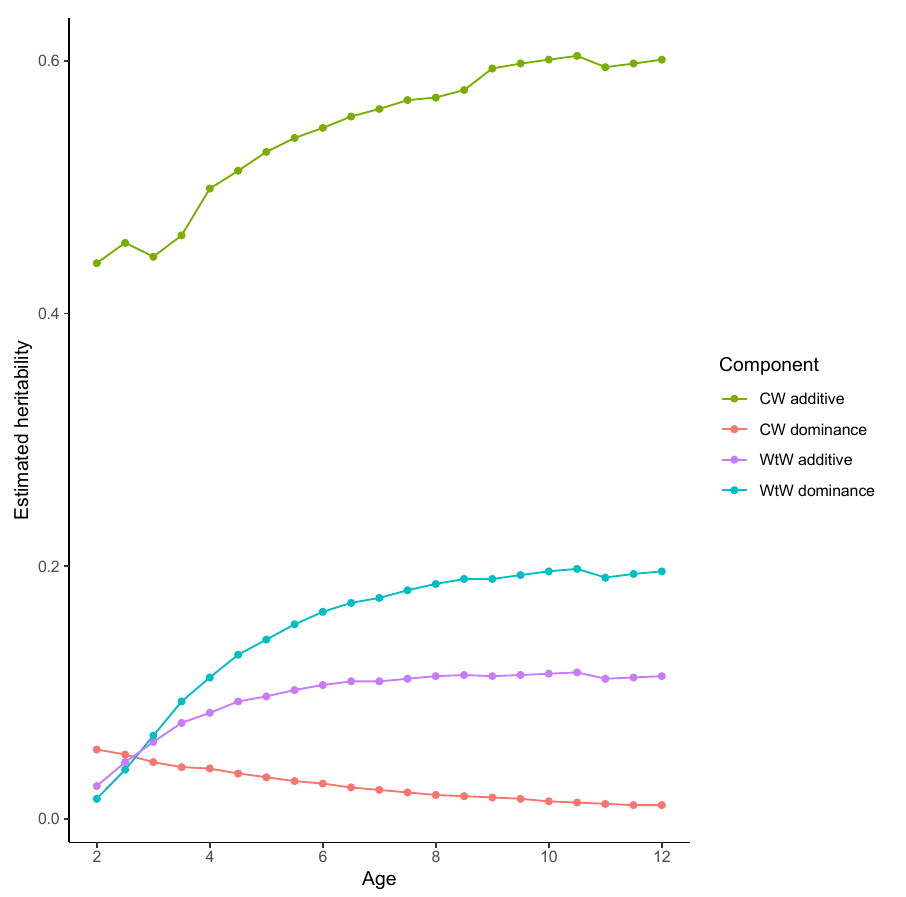
Figure 1. Projected additive and dominance heritability estimates from random regression analysis of cow weight (CW) and cumulative weight weaned (WtW).